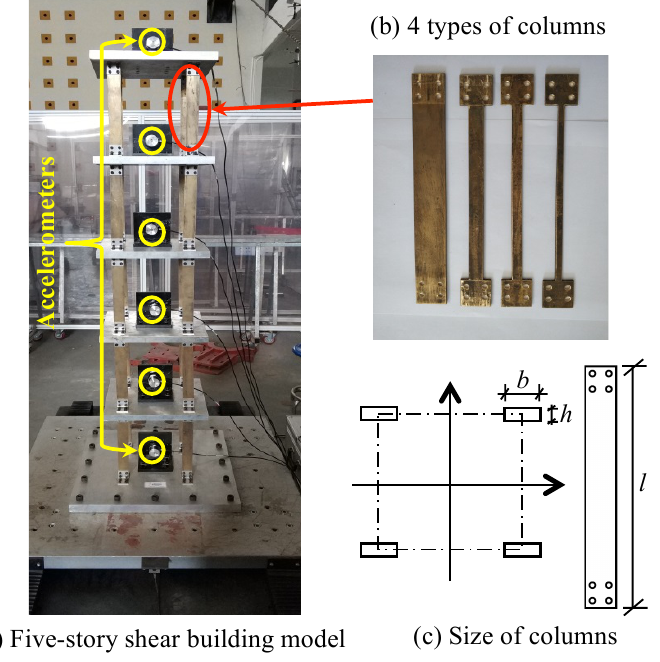
Figure 15. Experimental setup of five-story shear framework model. ( a ) Five-story shear building model ( b ) 4 types of columns. ( c ) Size of